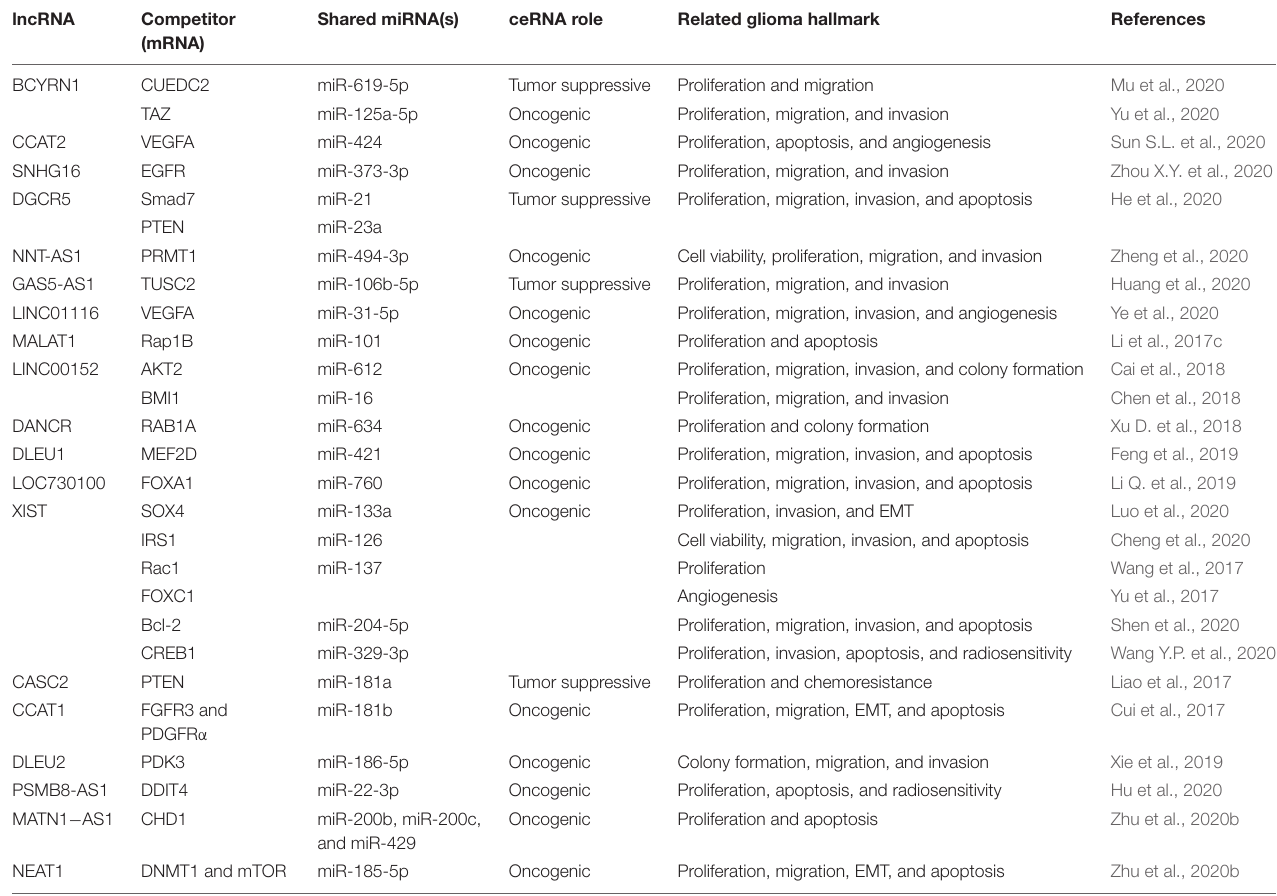
TABLE 1 | Representative lncRNA-mediated ceRNETs in